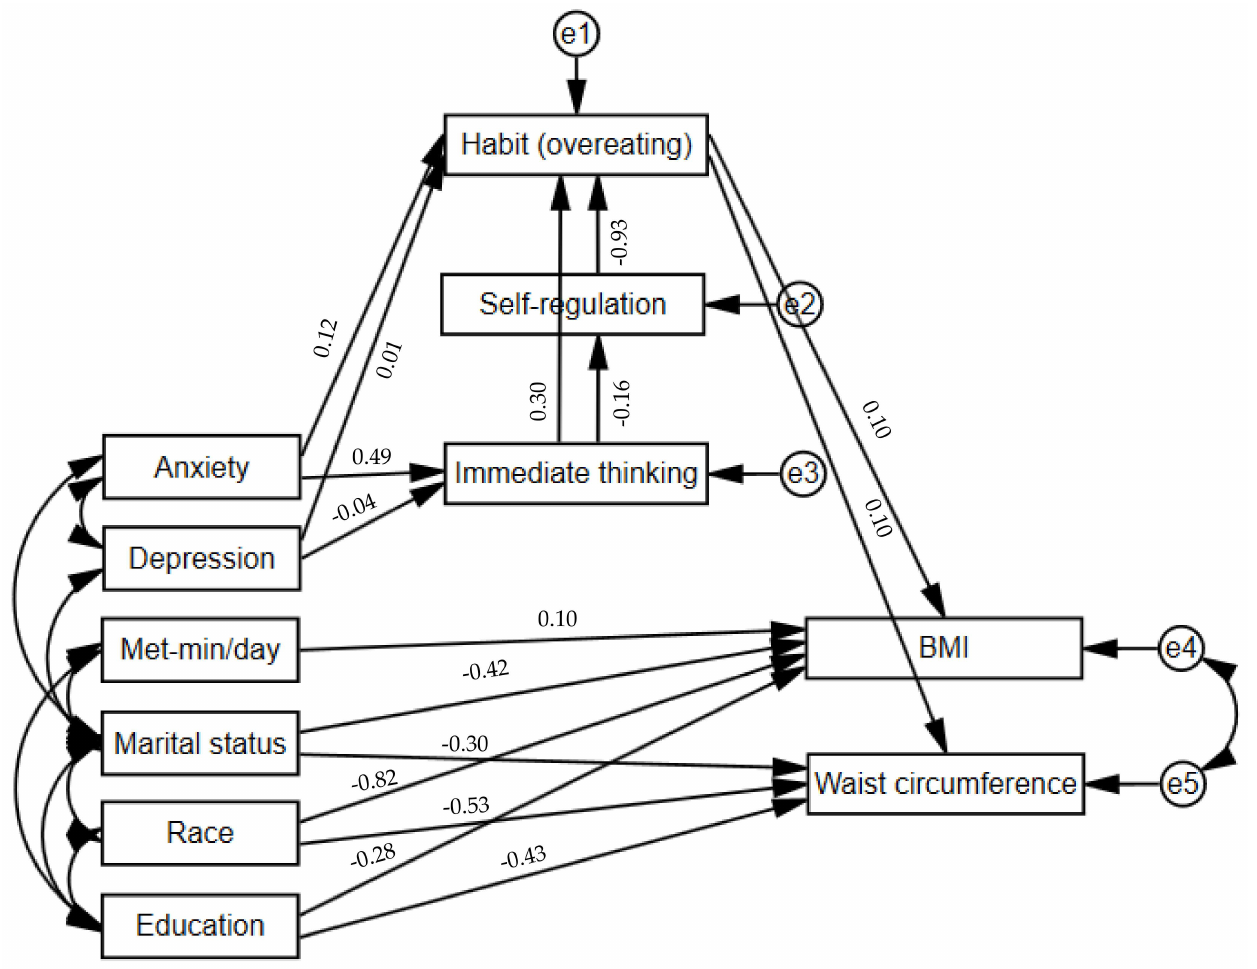
Figure 1. Hypothesized conceptual model that explains the relationships among the examined variables. Note: Met-min/day = Metabolic Equivalent Task–minutes/day; BMI = body mass index; e1–e5 represent individual error terms for each endogenous/dependent variable. Double-arrowed lines represent covariances. Path coefficients of each relationship are shown on each